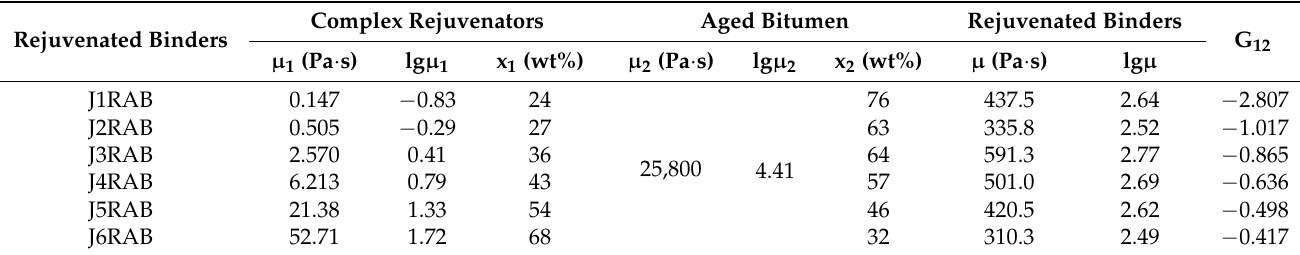
Table 9. G 12 parameter of rejuvenated binders with RJ-based rejuvenators. Rejuvenated Binders